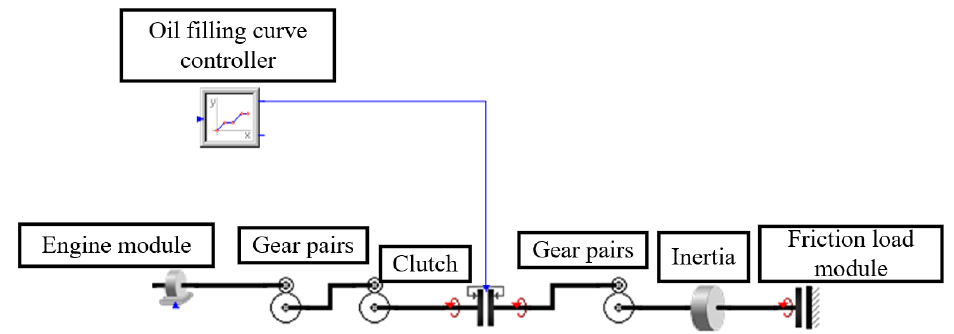
Figure 4. Simulation test platform for the oil filling control strategy of the wet clutch.